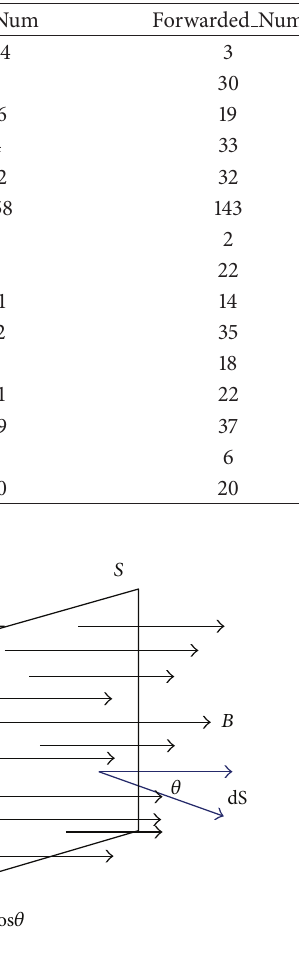
Figure 3: The magnetic flux in a magnetic